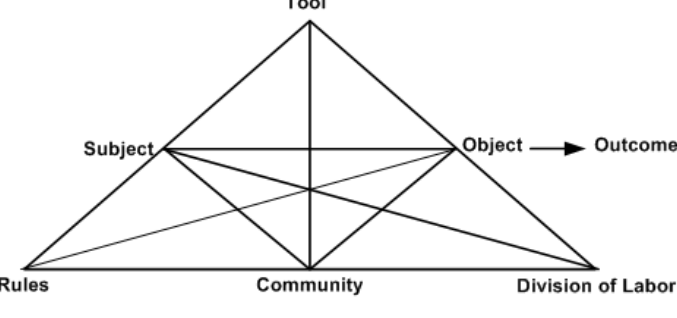
Figure 1. Activity Systems Analysis